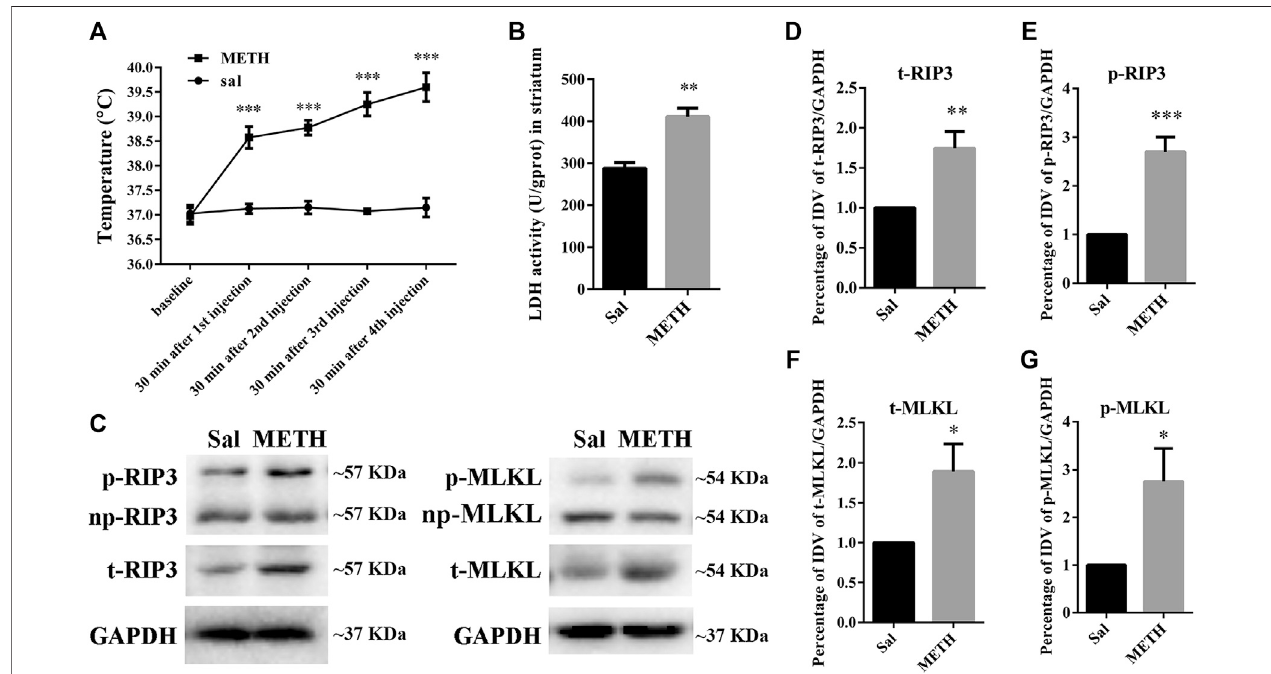
FIGURE 1 | Changes in core body temperature, LDH activity, and canonical necroptotic factors expression in the striatum of rats following METH administration. Rats were sacri fi ced by decapitation at 24 h after the last injection of METH (4 × 10 mg/kg, every 2 h, i.p.) or saline. (A) METH treatment increased core body temperature.Datawereanalyzed byRMtwo-wayanalysisofvariance(ANOVA)whichwascarriedoutwithGraphPad Prism5software( n (cid:2) 3).*** p < 0.001vs. baseline. (B) Necrosis in the striatum of rats was determined by LDH cytotoxicity assay. Data were analyzed by unpaired 2-tailed Student ’ s t test ( n (cid:2) 3). ** p < 0.01 vs. Sal group. (C) p-RIP3, RIP3, p-MLKL, and MLKL protein levels in the rat striatum were detected by phos-tag SDS-PAGE and WB after METH administration. (D – G) Statistical analysis of WB of p-RIP3, RIP3, p-MLKL, and MLKL expression. np, non-phosphorylated protein; t, total protein; Sal, saline group. Data were analyzed